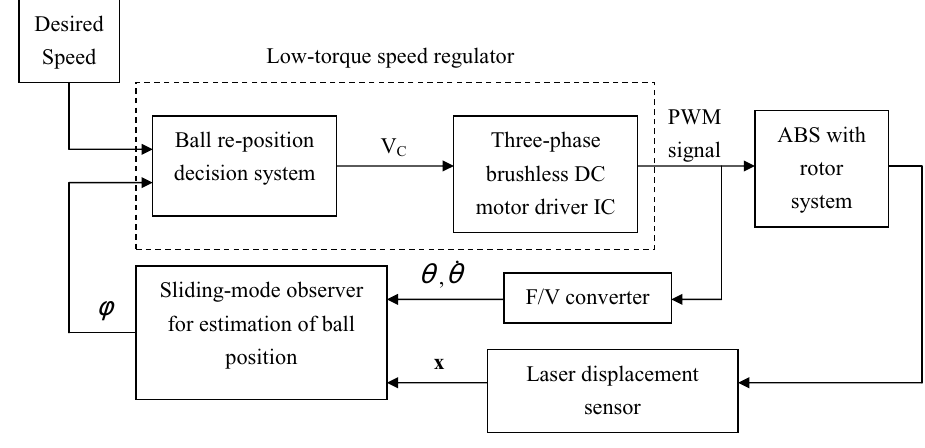
Fig. 6. Block diagram of the overall ball re-positioning